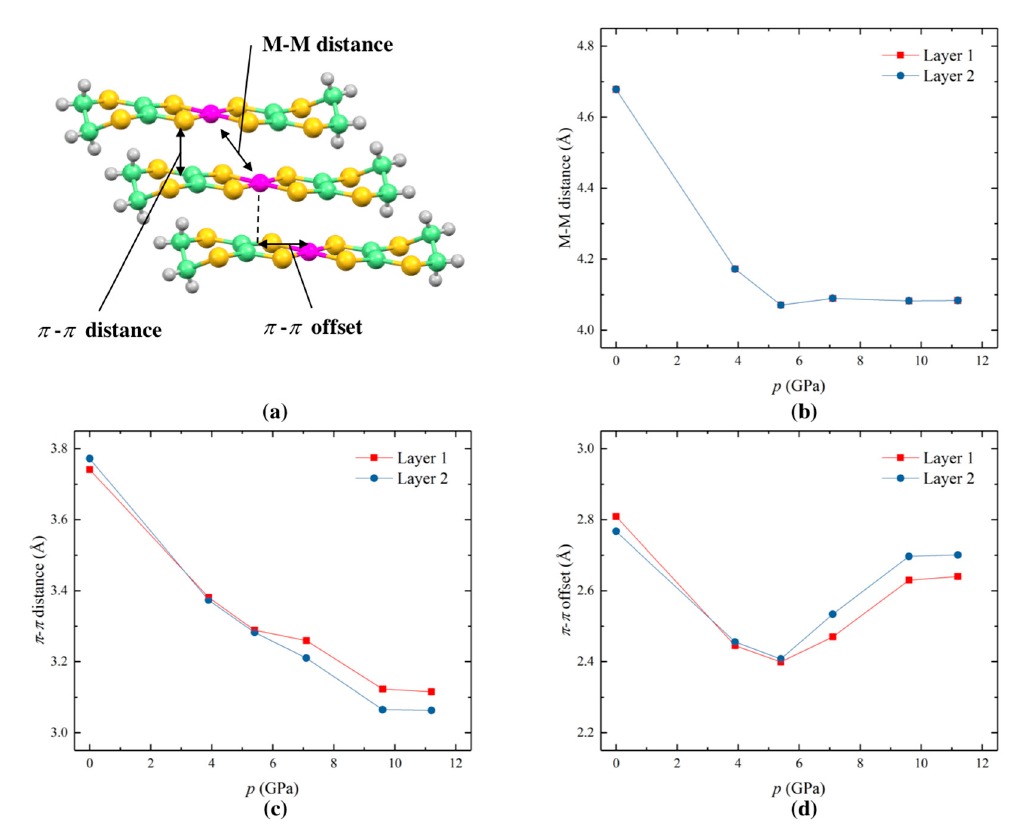
Figure 4. Changes in intermolecular distances in [Ni(dddt) 2 ], shown in ( a ), as a function of pressure for crystallographically-independent Layer 1 and Layer 2. ( b ) Metal–metal distance (note that values for Layer 1 and Layer 2 are equivalent and therefore overlap), ( c ) π - π distance, and ( d ) π - π offset.